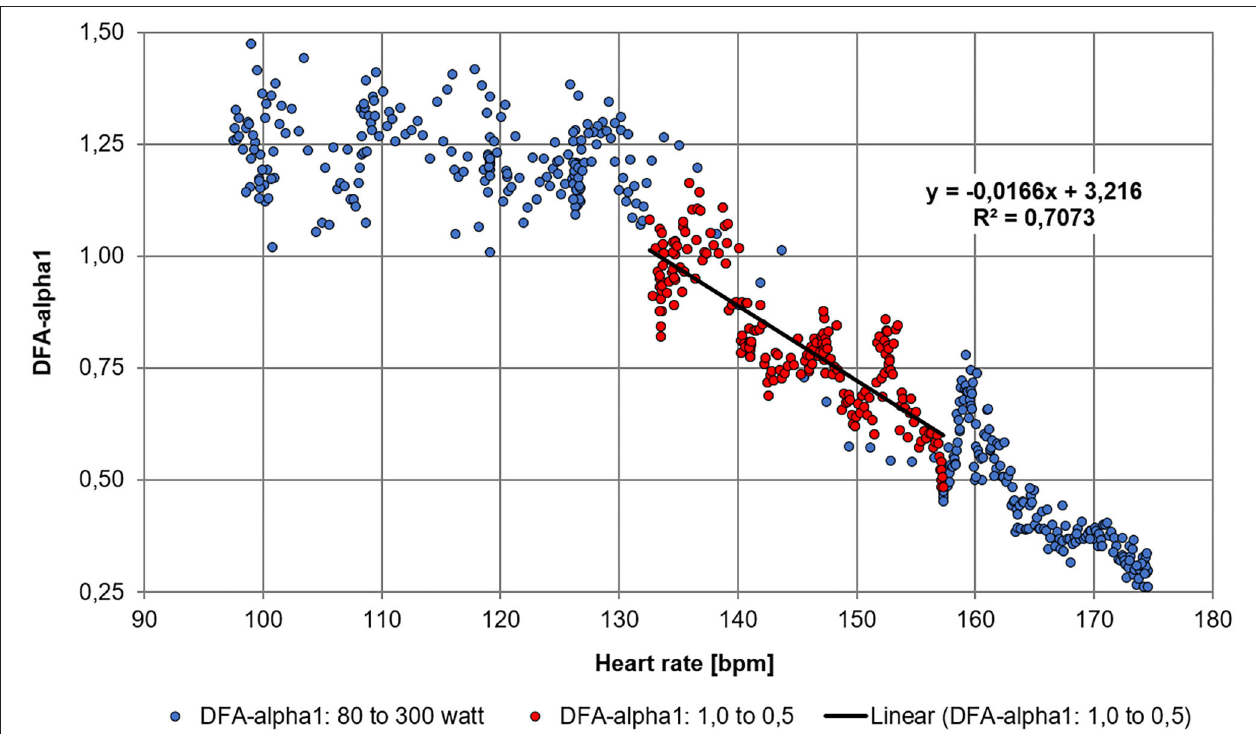
FIGURE 1 | Time-varying results of DFA-alpha1 processed in Microsoft Excel with an equation for linear regression; DFA-alpha1 plotted against heart rate, the area of linear drop of DFA-alpha1 from 1.0 to 0.5 is used to determine the HR at HRVT, here at 148 bpm.